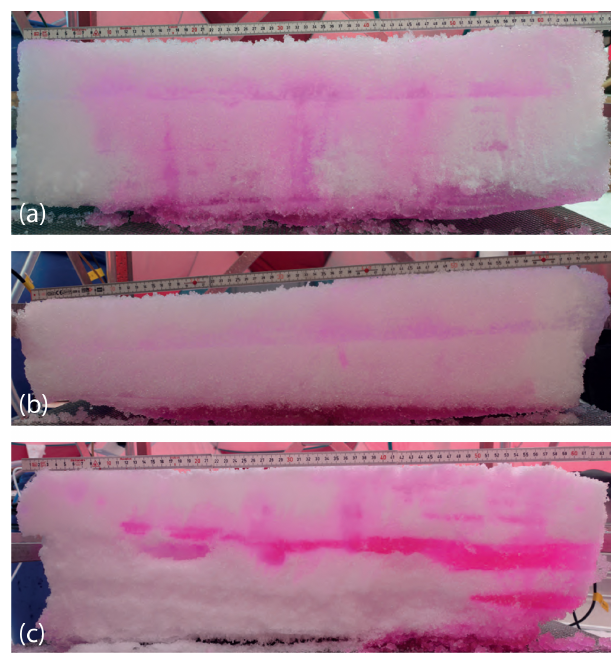
Figure 7. Three examples of firn and snow block sections after wa- ter percolation showing preferential flow paths and structural het- erogeneity. Figures (a) and (b) are firn samples ( firn3, firn6 ) where higher concentrations of dyed water highlight icy layers and prefer- ential flow fingers, whereas figure (c) , displaying the sample after experiment snow , shows that in mature snow dye accumulates in finer-grained layers due to capillary